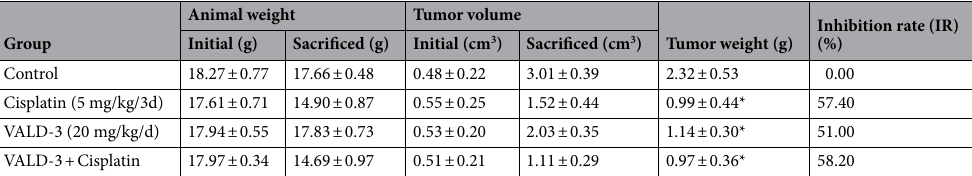
Table 1. Tumor growth parameters of VALD-3 treatment on the breast cancer xenografts model. *P < 0.05 compared with the control group with significant